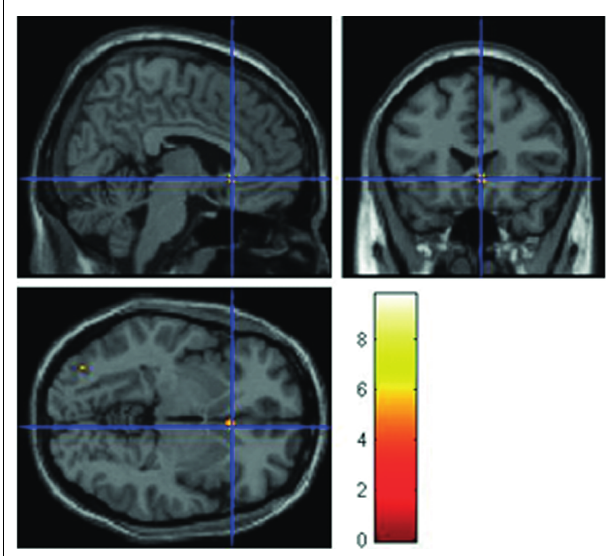
FIGURE 5 | Main effect of possibility of confrontation on response type. The peak activation is localized in subgenual ACC (6 22 − 4, p < 0.023, FEW corrected).The color-bar corresponds to T -values.